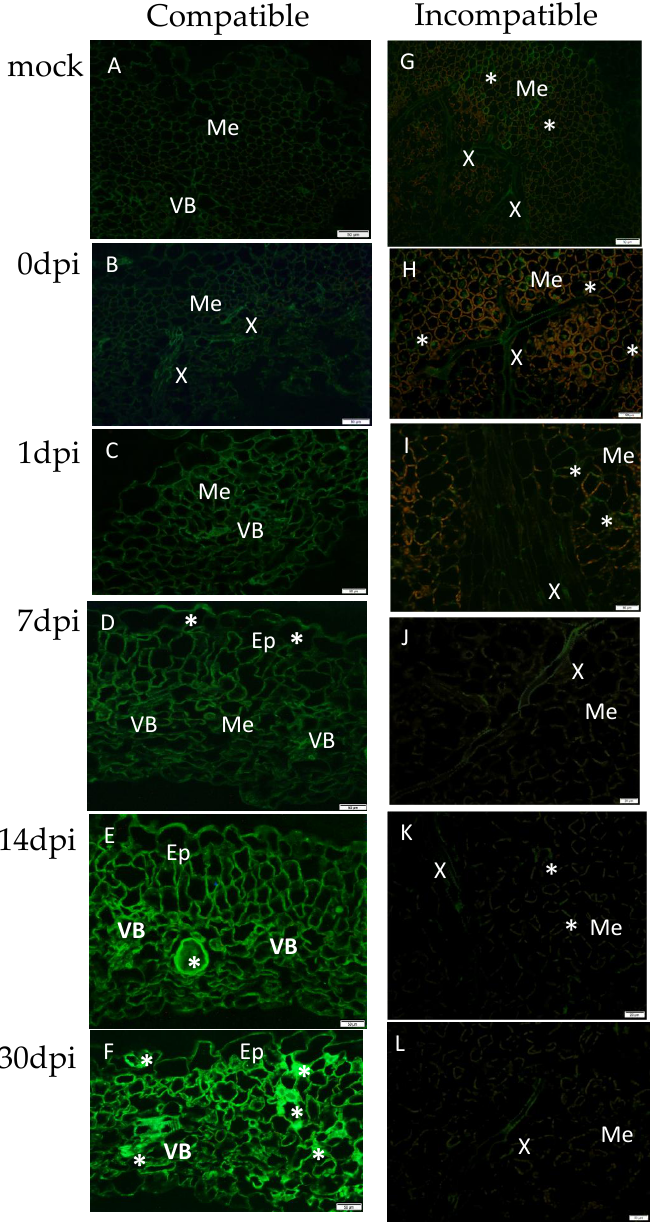
Figure 2. Immunofluorescence localization of Solanum tuberosum expansins (StEXPAs) in PVY NTN –potato Irys compatible ( B – F ) and –potato S á rpo Mira incompatible ( H – L ) interactions. ( A ) StEXPA green fluorescence signal in the vascular bundle and parenchyma cells in a mock-inoculated Irys potato leaf. ( B ) StEXPA green fluorescence signal in xylem tracheary elements and